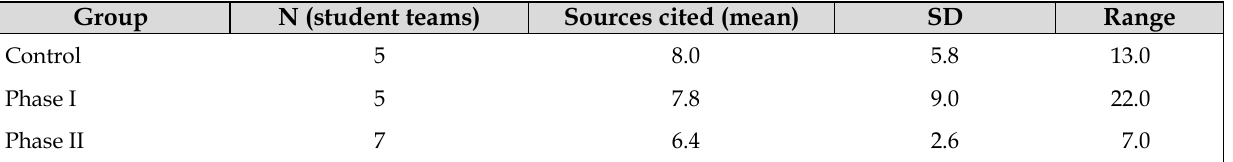
Table 4 Student citation patterns in design project documentation